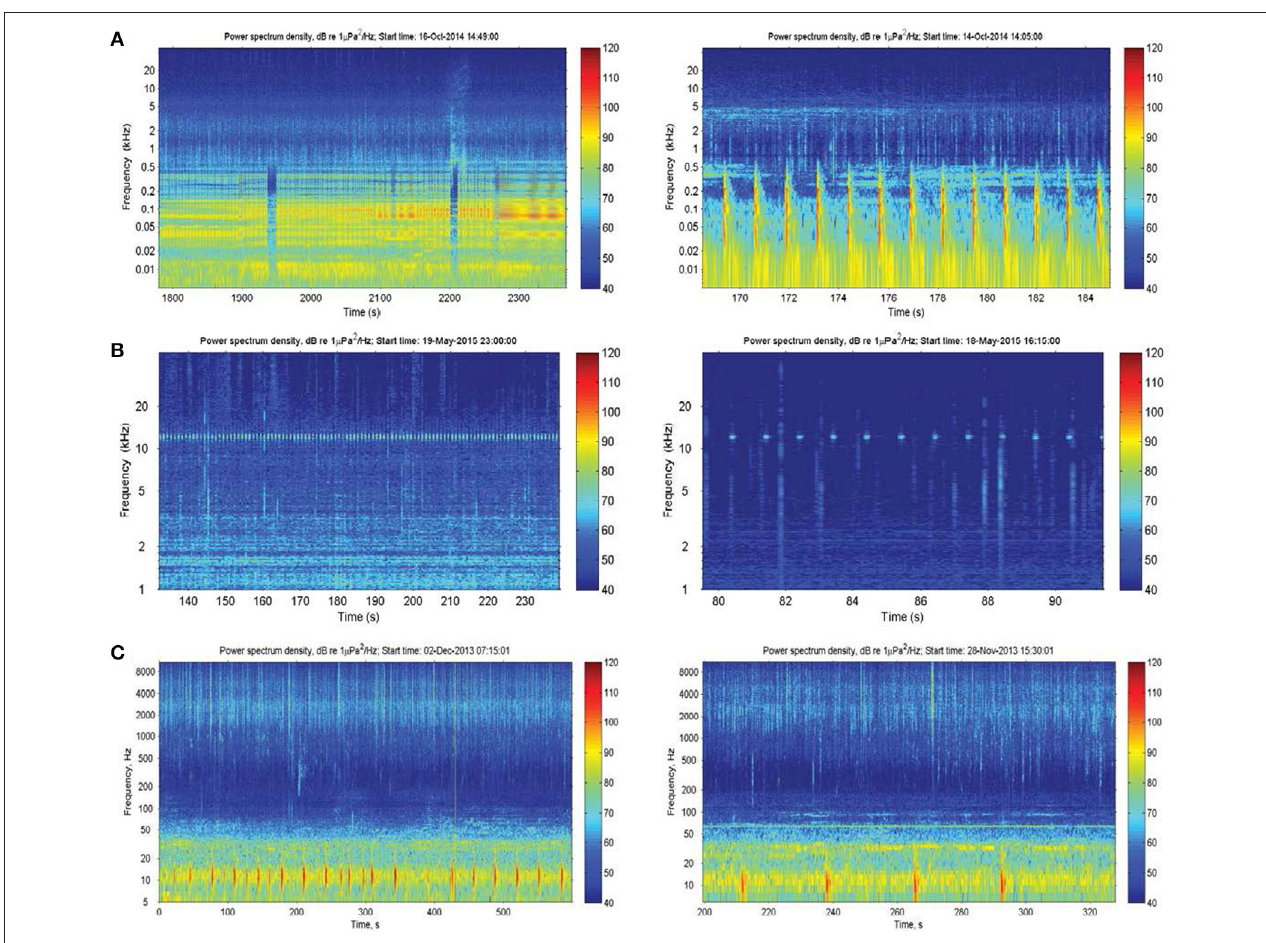
FIGURE 3 | Anthropogenic sound sources within the Swan River included: (A) pile-driving; (B) vessel echosounders; and (C) unknown series of low-frequency impulses thought to originate from vehicle